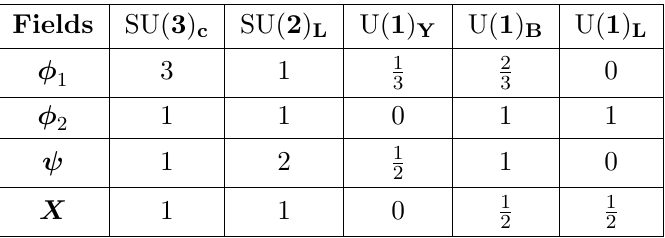
Table 1 . New (cid:12)elds of the UV model with their